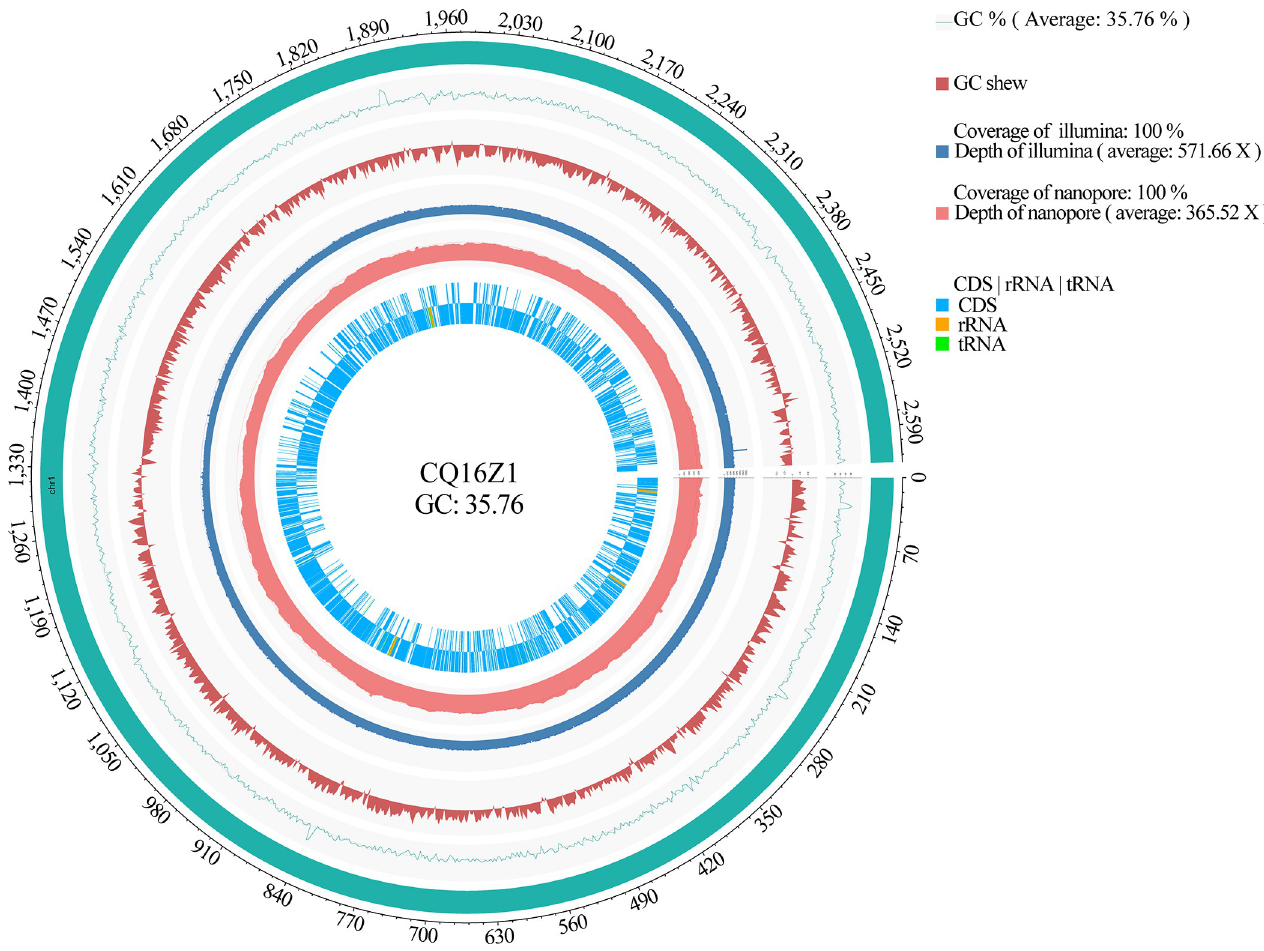
Fig 1. Genome circle of Companilactobacillus futsaii subsp. chongqingii CQ16Z1.